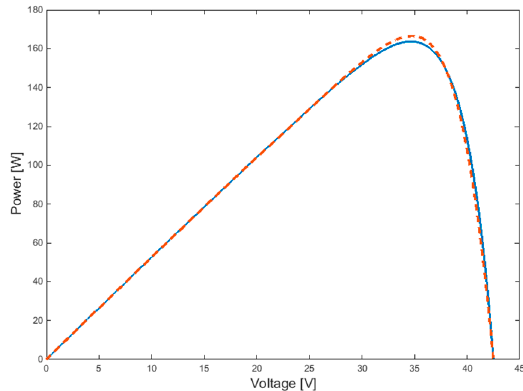
the datasheet (dotted line).